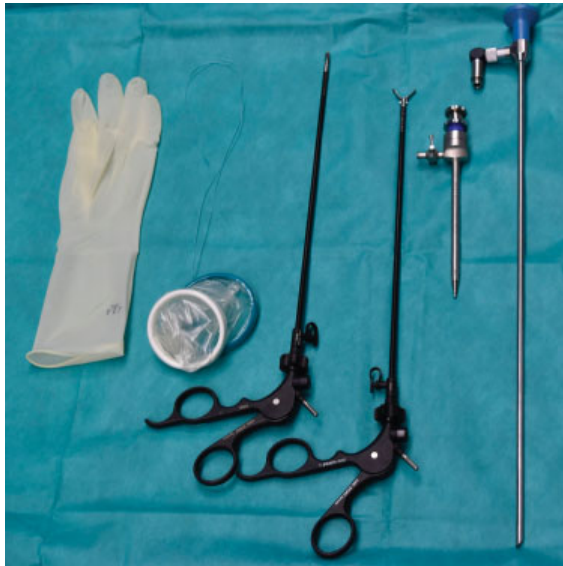
Fig. 1 Equipment used for single-incision pediatric endosurgery with glove port.